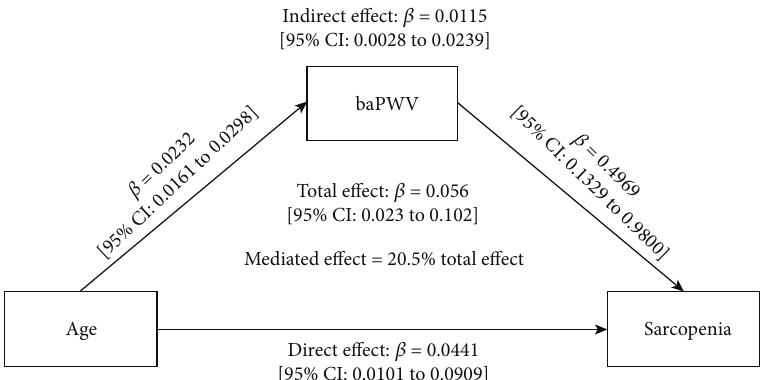
Figure 1: baPWV mediated 20.5% of the positive relationship between increased age and the prevalence of sarcopenia among Chinese patients with T2DM. Adjusted for sex, smoking status (ever or never), drinking status (ever or never), systolic blood pressure, vibration perception threshold classes ( < 15, ≥ 15 V), body mass index classes ( < 24, ≥ 24 kg/m 2 ), alanine transaminase, creatinine, albumin, low-density lipoprotein cholesterol, vitamin D, hemoglobin A1c classes ( < 7, ≥ 7%), and diabetes duration classes ( ≤ 10, > 10